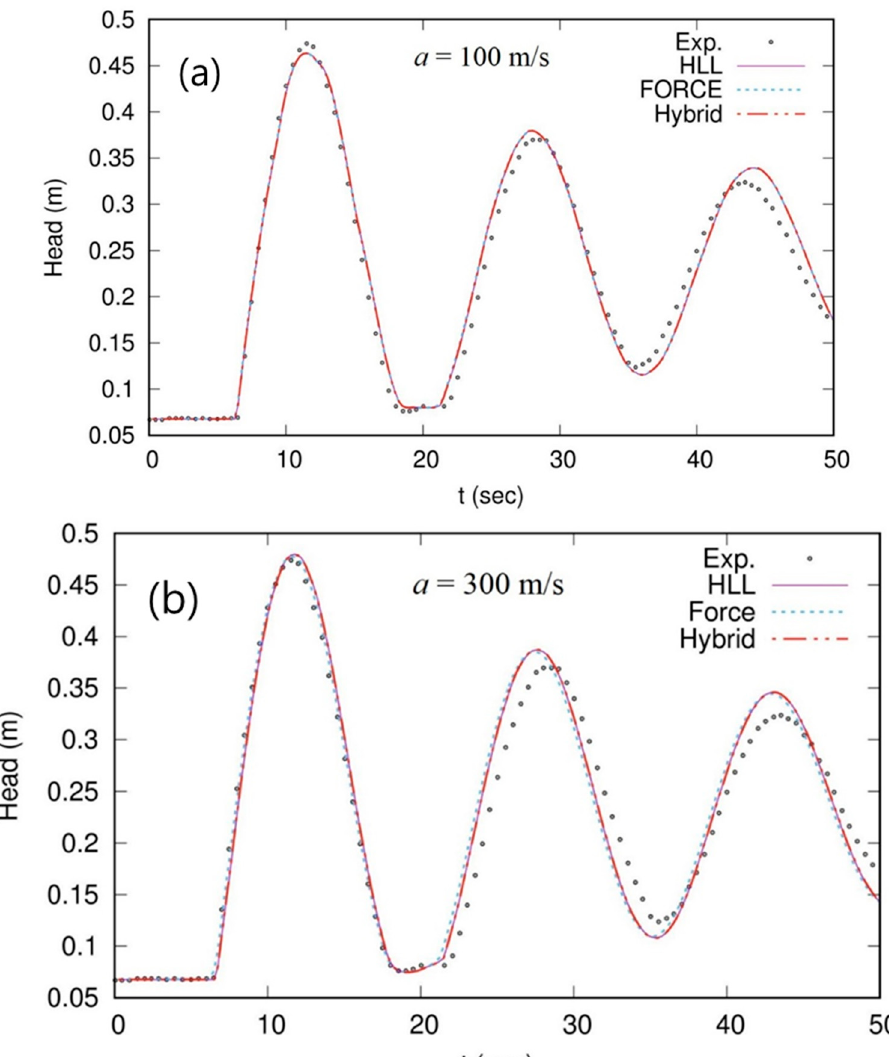
Figure 3. Temporal variations of water level at downstream tank (Test 2) with ( a ) a = 100 m/s; ( b ) a = 300 m/s.